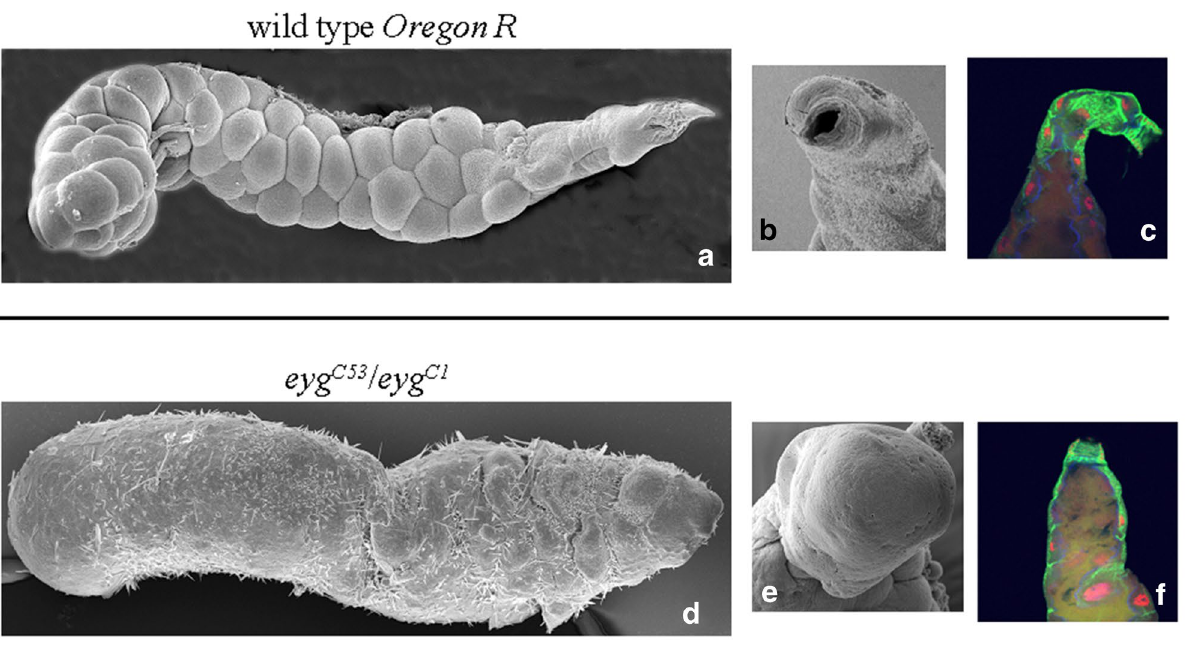
Figure 2. SG phenotype in eyg C1 / eyg C53 mutants. ( a ) Longitudinal SEM view of the wild-type ( Oregon R ) SG